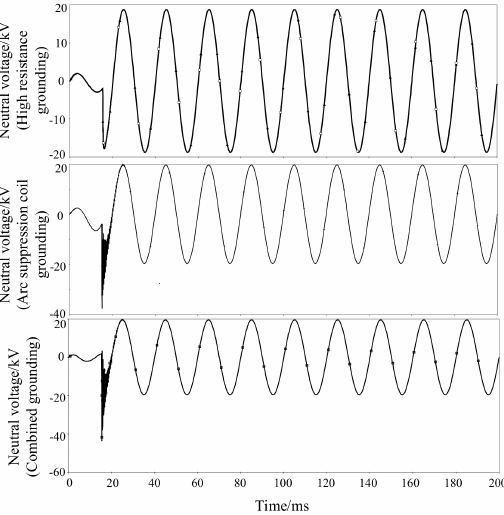
Figure 7. Neutral voltage drift of metallic